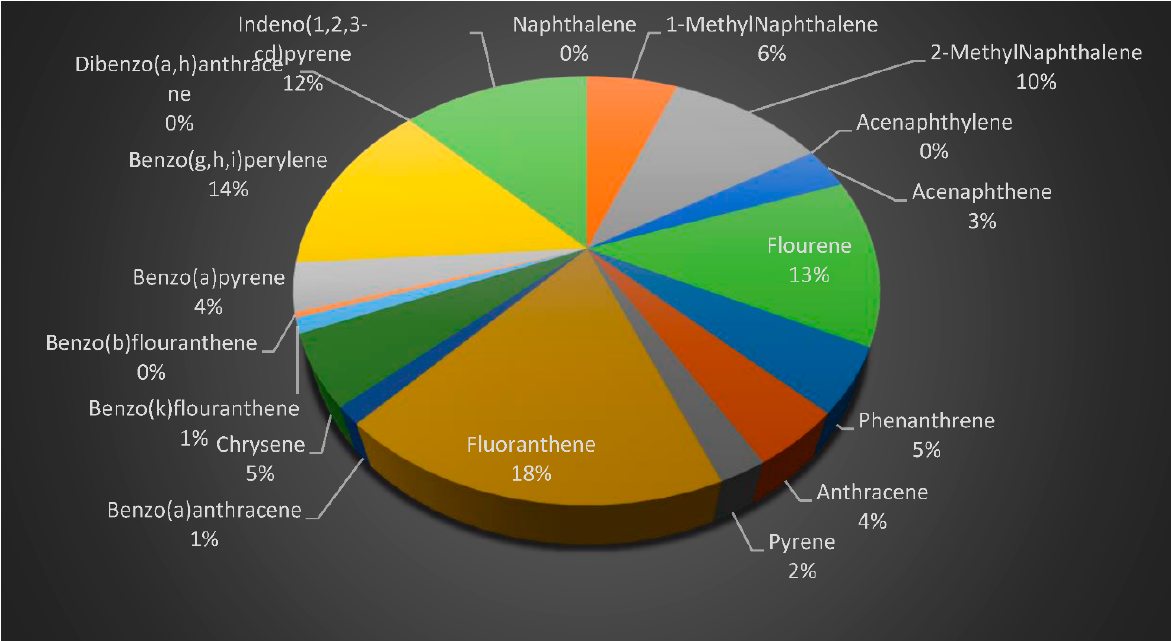
Figure 8. Percentage contributions of PAHs in the soil samples.